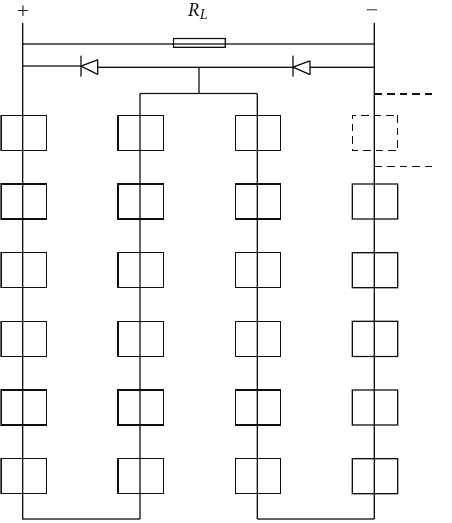
Figure 5: The method of the experiment.